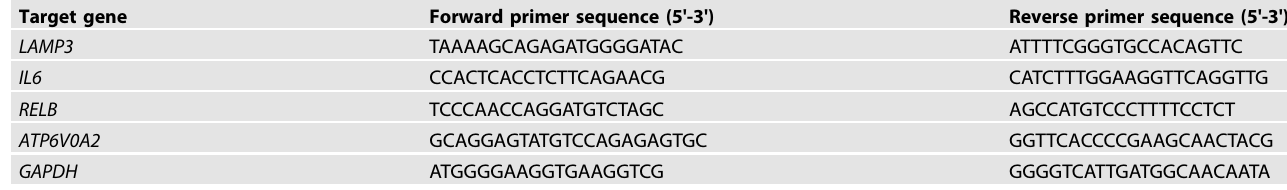
Table 3. List of qRT-PCR